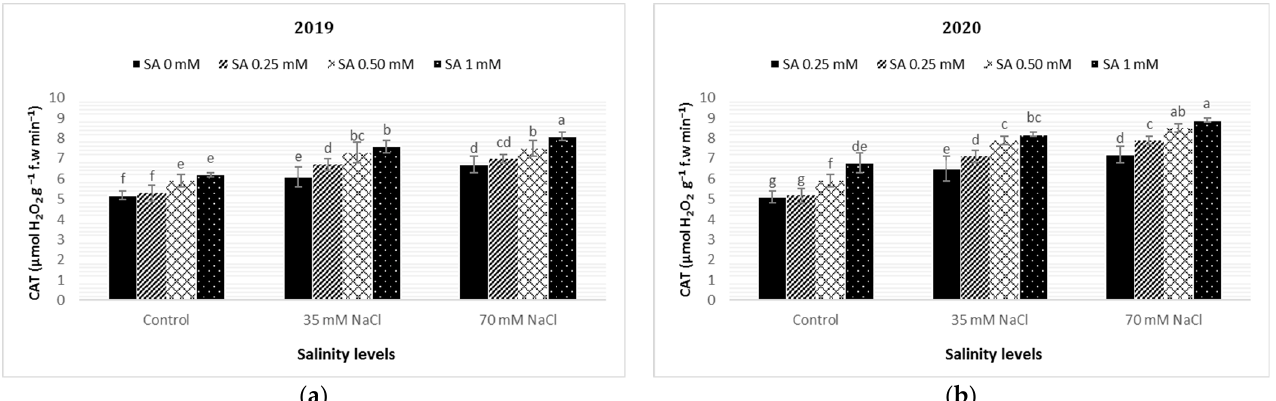
Figure 1. Catalase (CAT) activity in pomegranate plants cv. “Wonderful” subjected to different salicylic acid (SA) treatments under salinity stress conditions in ( a ) 2019 and ( b ) 2020 seasons. The vertical bars with different letters are statistically different, indicating an interactive effect of salicylic acid treatments and salinity levels according to LSD test ( p < 0.05). Vertical bars indicate the mean ± SE.